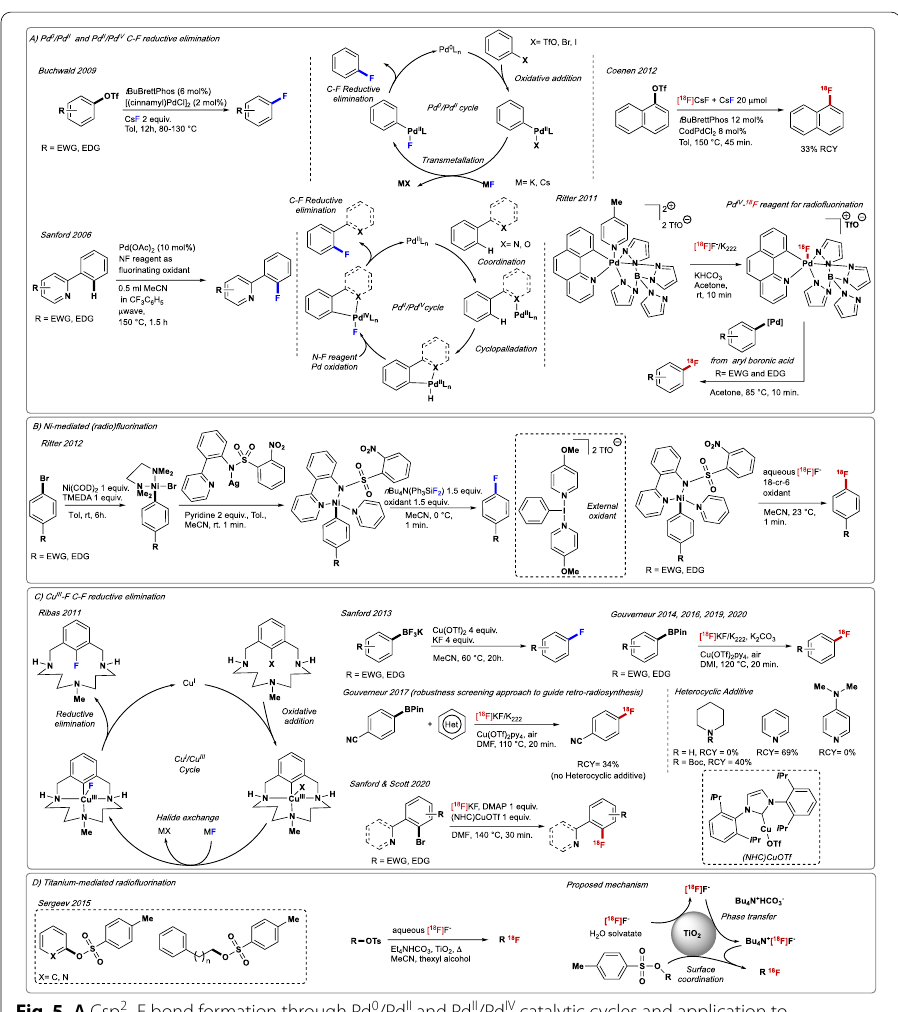
Fig. 5 A Csp 2 –F bond formation through Pd 0 /Pd II and Pd II /Pd IV catalytic cycles and application